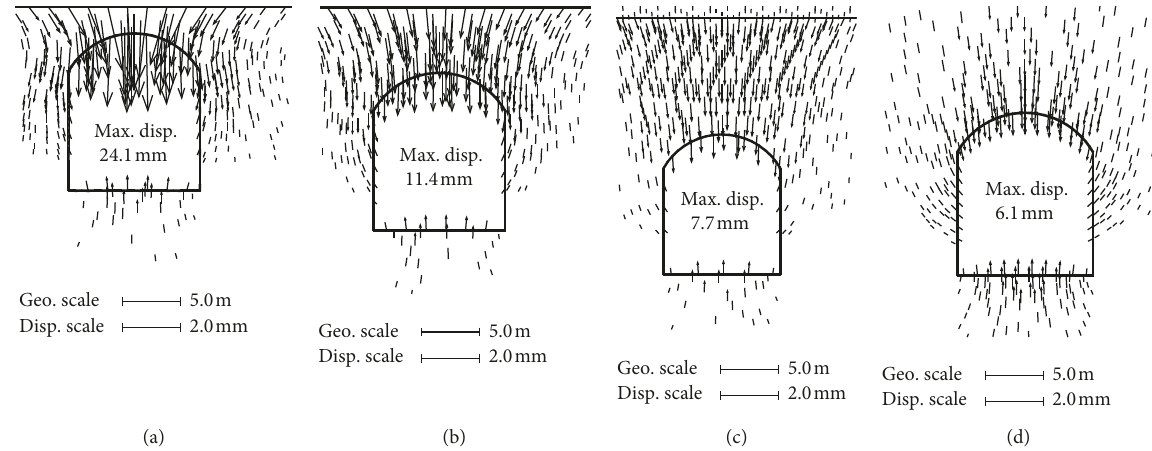
Figure 7: Displacement vector fields of the surrounding rock mass with different fault distance cases: (a) 0.2 spans; (b) 0.5 spans; (c) 1.0 span; (d) no